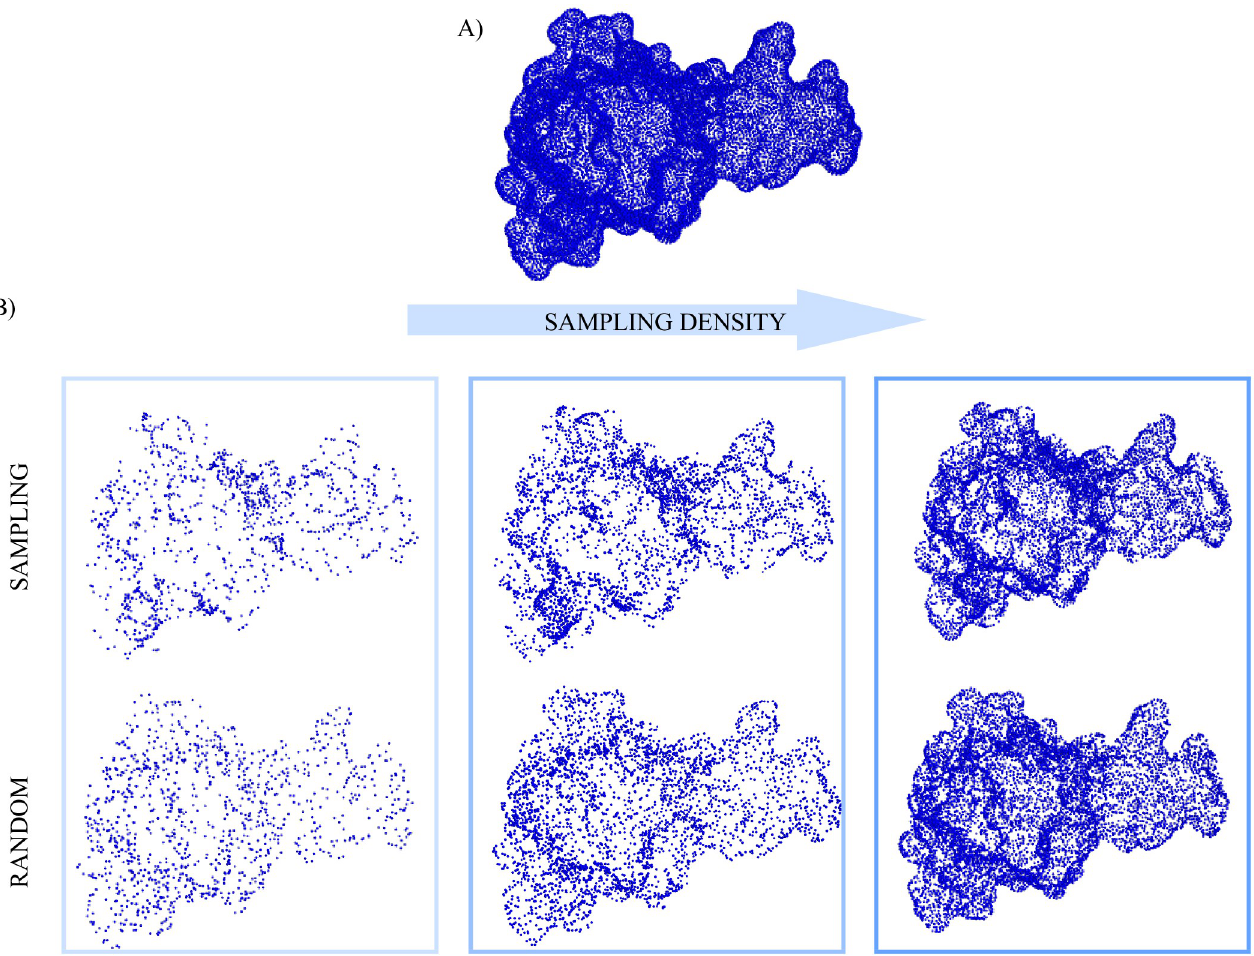
Fig 6. Visualization of the 3D surfaces reconstruction. A) 3D reconstruction of the A1 surface from all its surface points. B) The three columns depict the reconstruction of the same surface, with an increasing sampling density. In each column, the first row shows the reconstruction with a subset of the original points selected with the sampling, whereas the second row shows the reconstruction with a subset that counts the same number of points selected with the sampling, but in this case randomly extracted.